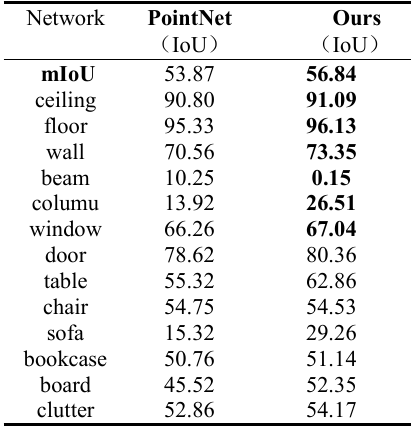
Table 5. IoU of Area5 in S3DIS Dataset Size of convolutiona